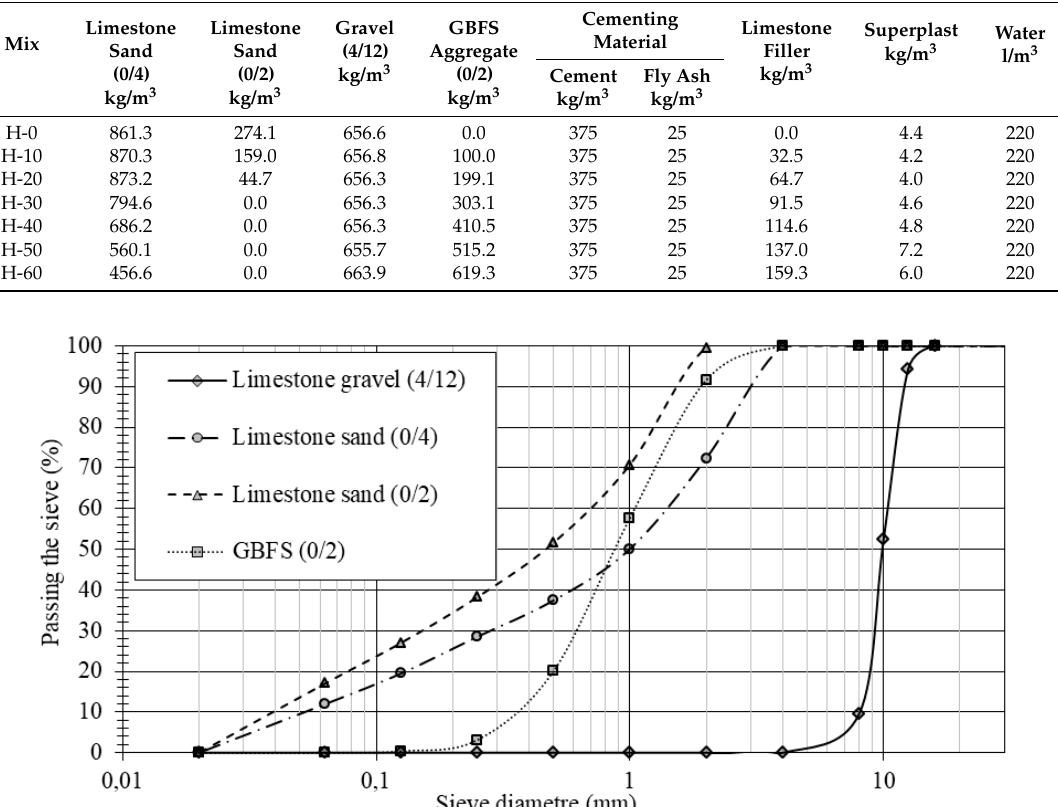
Figure 2. Micrographs of samples of granulated blast furnace slag.